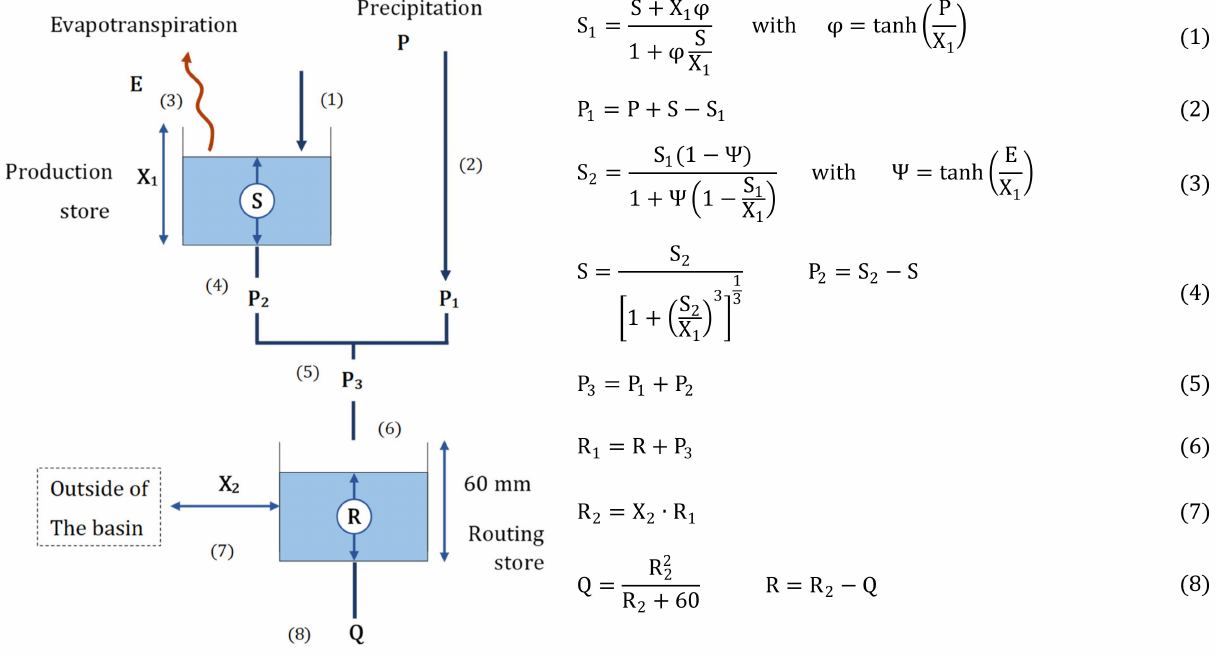
Figure 3. Structure of the GR2M model. (Source: Adapted from Bachir et al. [31]; Rwasoka et al. [32]). Additionally, some moisture content is released as surface water: P 2 (mm) and gradu- ally released with rainfall excess. This water section is called surface runoff or net rainfall: P3 (mm), which moved into the flow path combined with the remaining water from the ini- tial or existing water in the river: R (mm). It causes the water content at level R1 (mm). The water volume movement may change because some water may be lost, causing the residual water volume at the level: R 2 (mm). Ultimately, the total amount of water discharge into the runoff streamflow gauging station conducted the